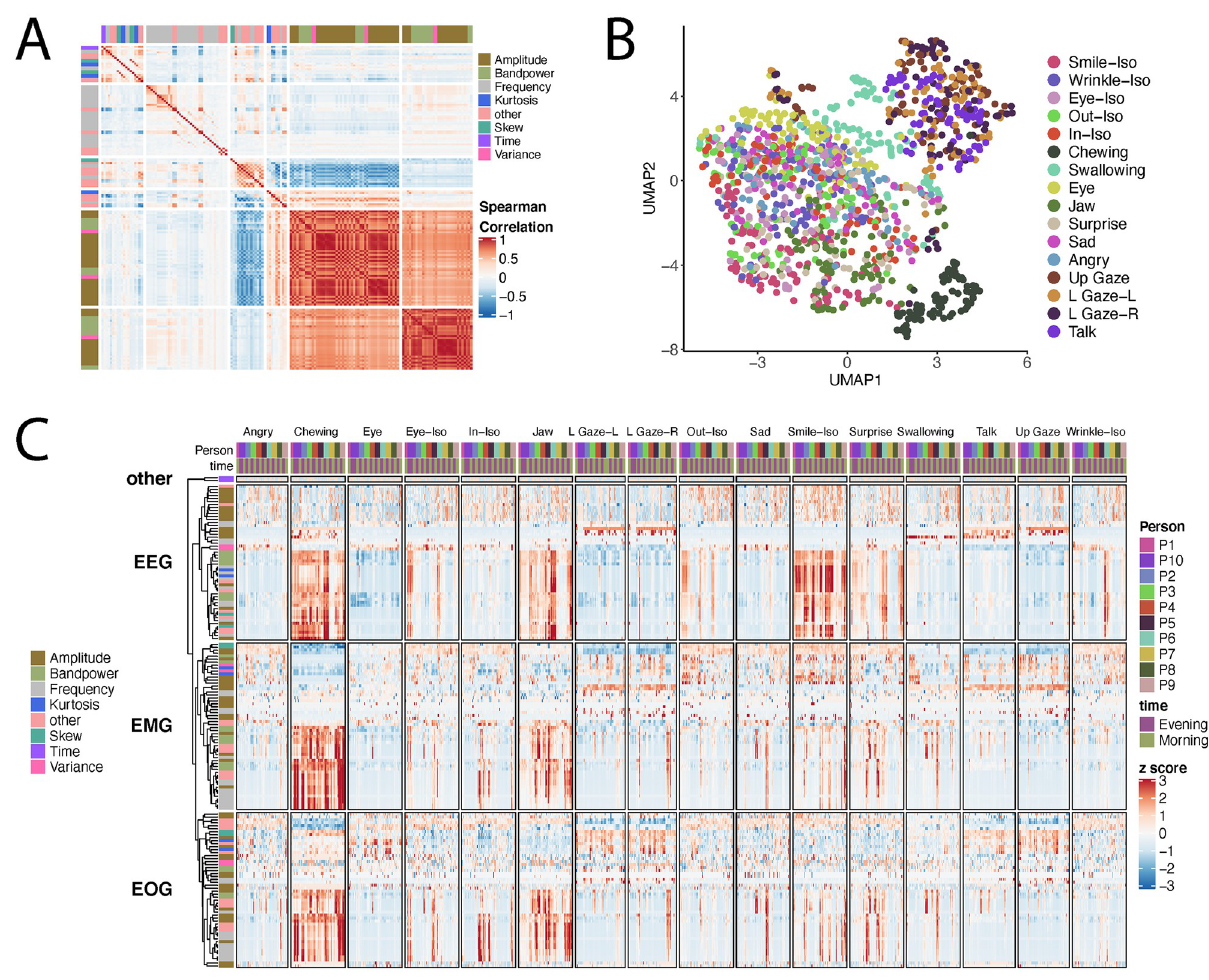
Fig 2. Dimensionality reduction and visualization of Earable features. A. Spearman correlation of all 161 Earable features against each other, represented as a heatmap. K = 6 clusters from K means clustering (optimal number) are shown. All 16 mock-PerfOs were pooled for the correlation analysis. B. UMAP dimension reduction of all 161 Earable features. Each individual activity repeat is a point on this graph. The color of the point represents the activities performed during that activity. C. Heatmap of all 161 Earable features (rows) for all activity repeats (columns). Columns are sorted first by the 16 activates in the pilot study, and within each activity, by participant, and then time of day when the activity was performed.